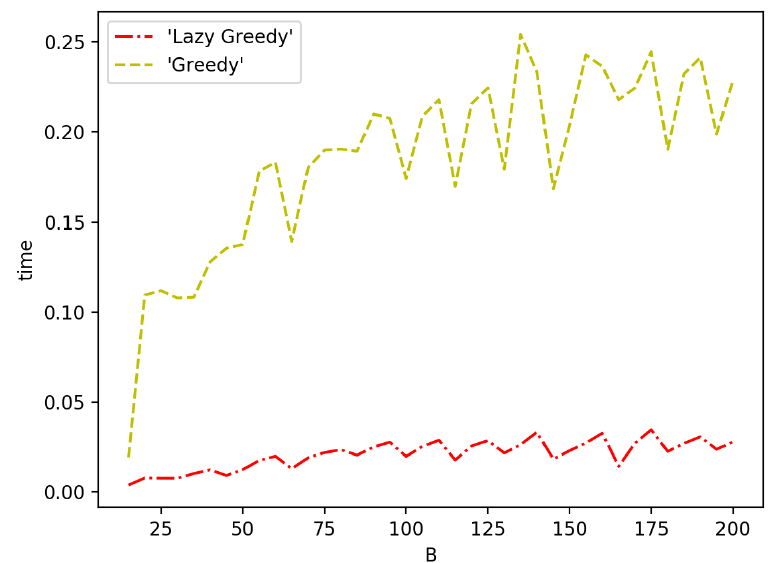
Figure 11. Greedy vs. lazy greedy for general